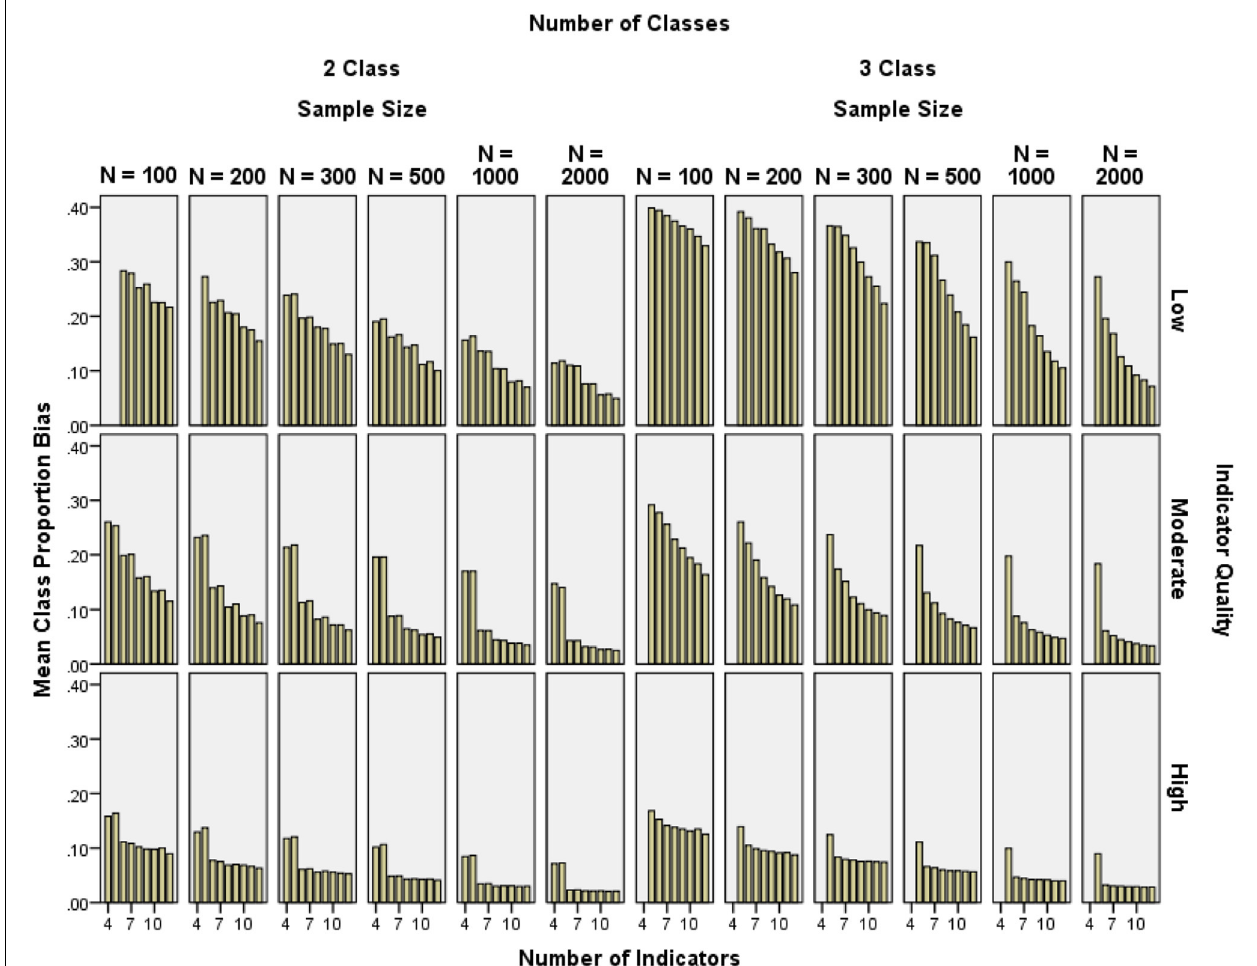
FIGURE 5 | Mean class proportion relative bias by indicator quality, number of indicators, and sample